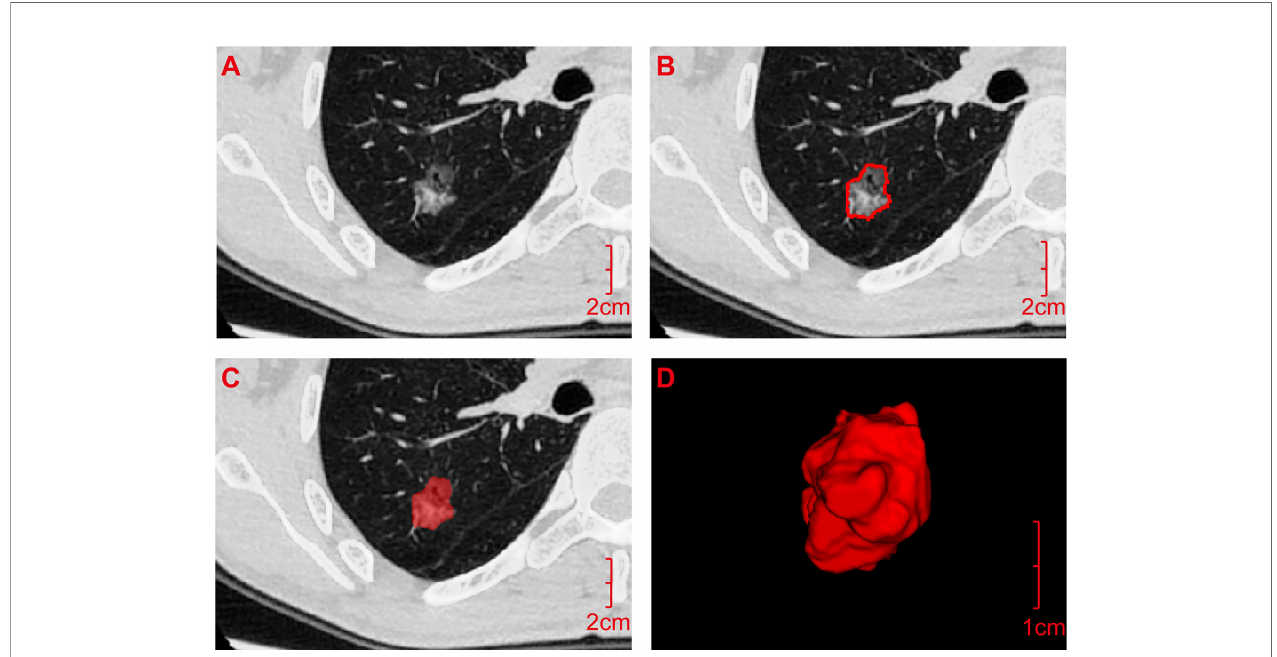
FIGURE 1 | Acquisition process for the radiomics features. (A) Digital Imaging and Communications in Medicine image of the transverse section of the ground-glass nodule was pre-processed by A.K. software and then imported into ITK-SNAP software. (B) ROI was manually outlined layer by layer along the inner edge of the lesion based on pixel points. (C) ROI was outlined. (D) It was fused and saved as an ROI three-dimensional image and imported into A.K. software together with the pre-processed original image (A) in batches to quantitatively calculate the radiomics features. ROI, Region of